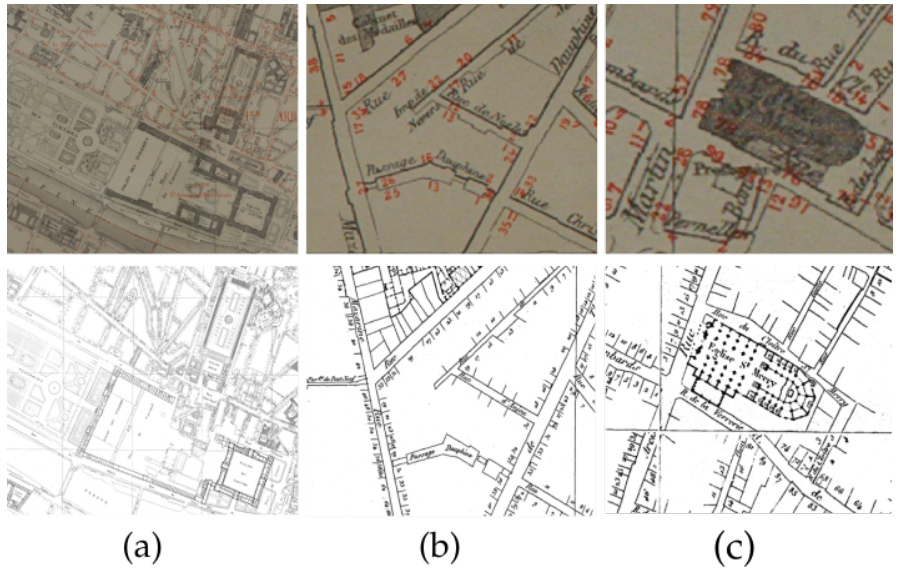
Figure 11. Samples of the georeferenced Alphand Atlas (2nd row) and Jacoubet Atlas (1st row) at different scales: ( a ) district and ( b ) urban islet. Column ( c ) shows how buildings are portrayed in the